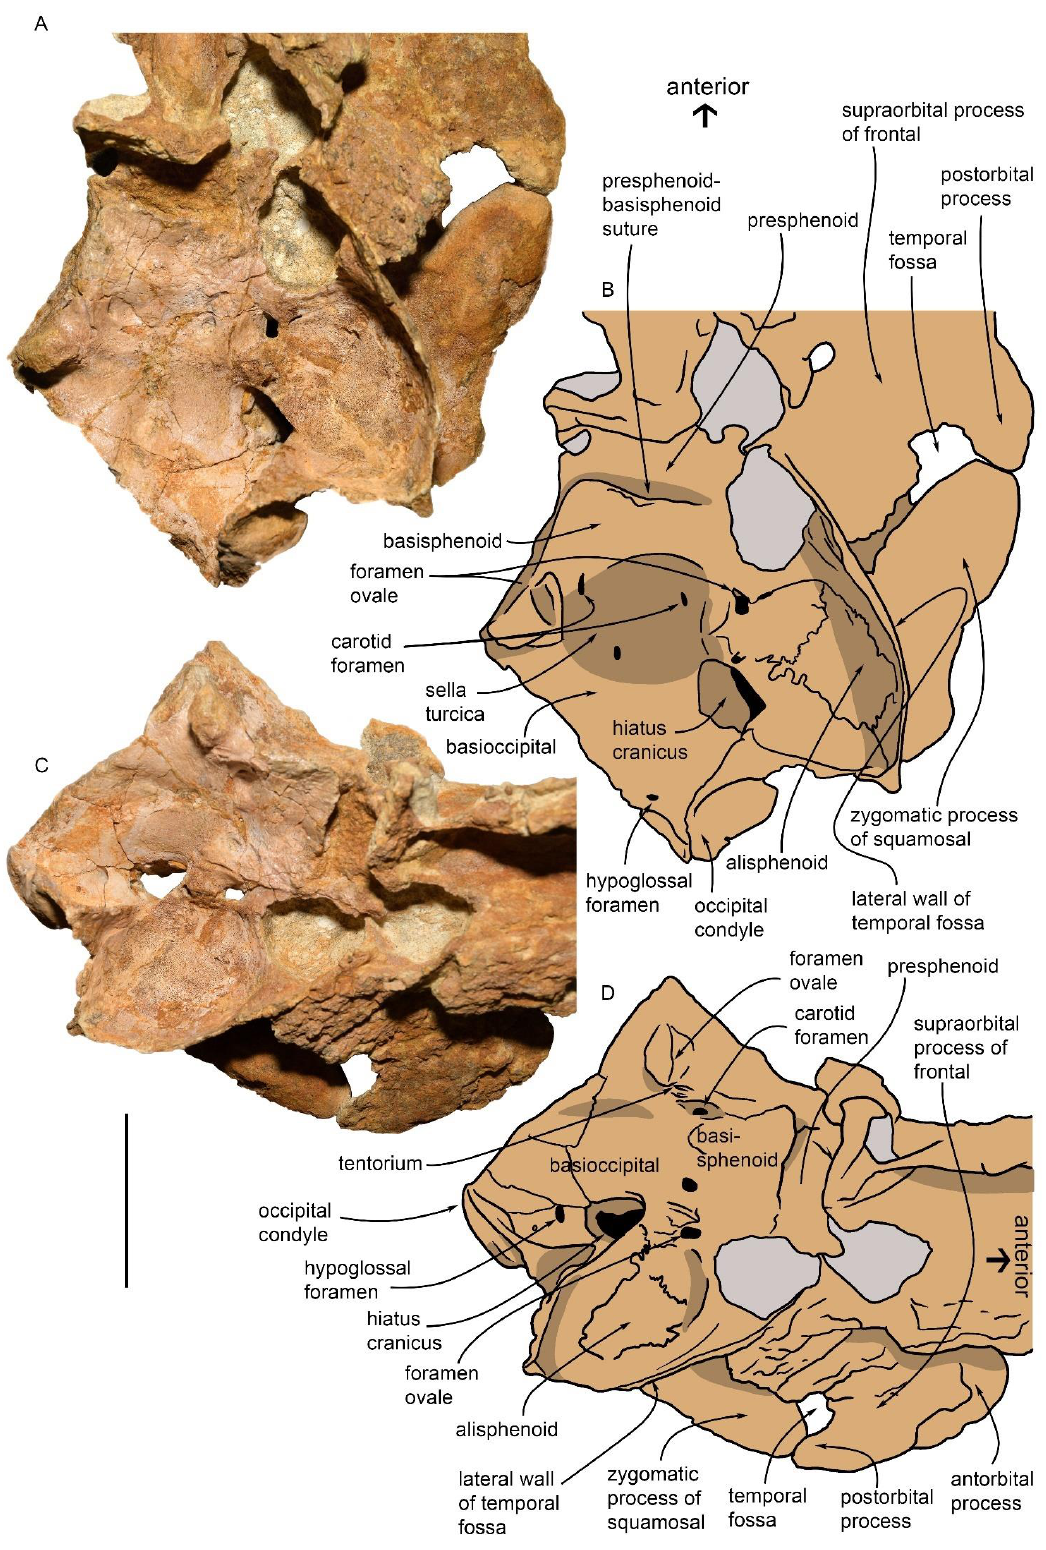
Figure 7. Basicranium of MGPT-PU 13881/1. ( A ) Photographic representation of the basicranium in dorsal view. ( B ) Anatomical interpretation of ( A ). ( C ) Photographic representation of the basicranium in right dorsolateral view. ( D ) Anatomical interpretation of ( C ). Scale bar equals 5 cm.